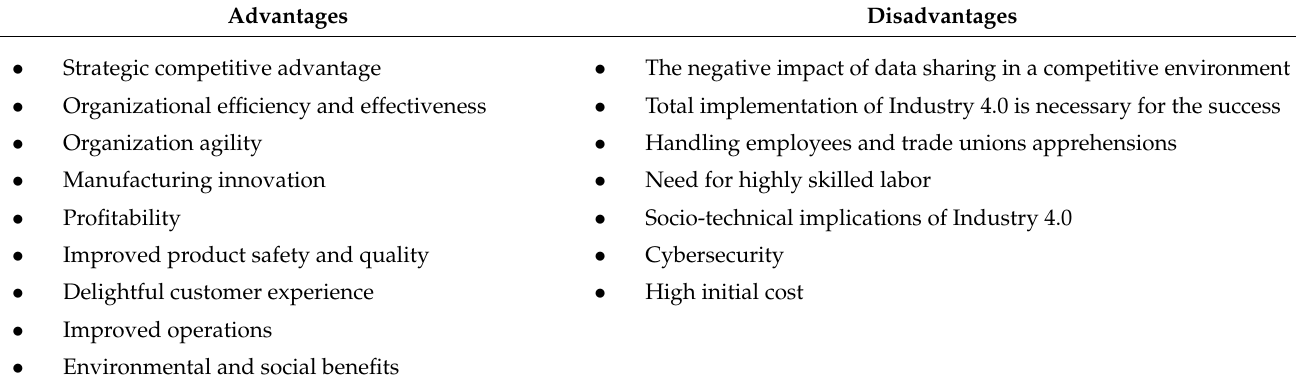
Table 1. The main pros and cons of